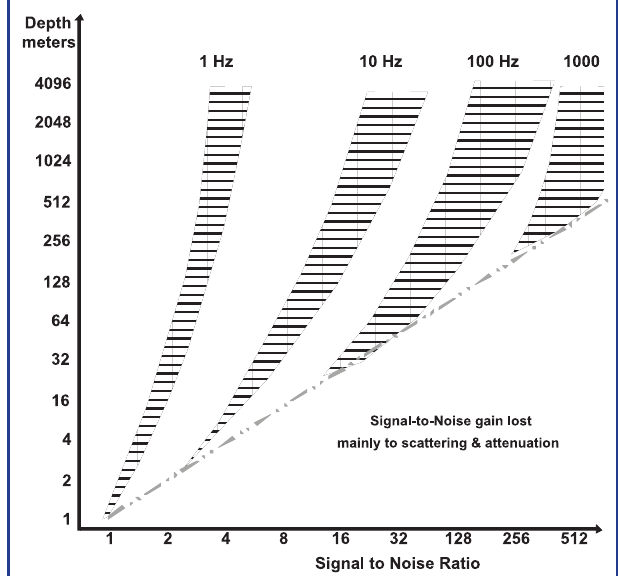
Figure 5 . Signal to noise improvement with depth (from Malin,